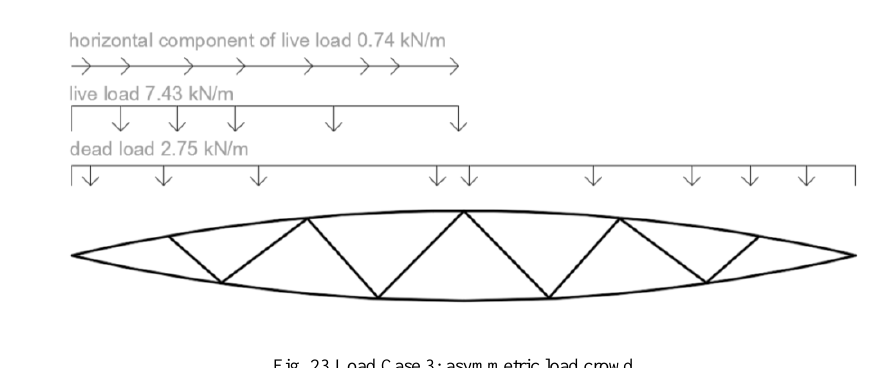
Fig. 23 Load Case 3; asymmetric load crowd.